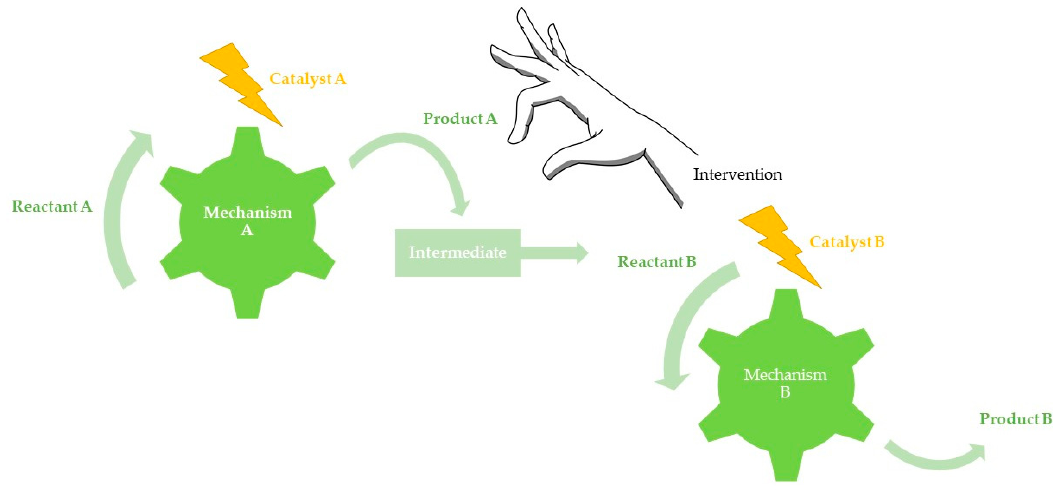
Figure 4. Schematic illustration of assisted tandem catalysis.